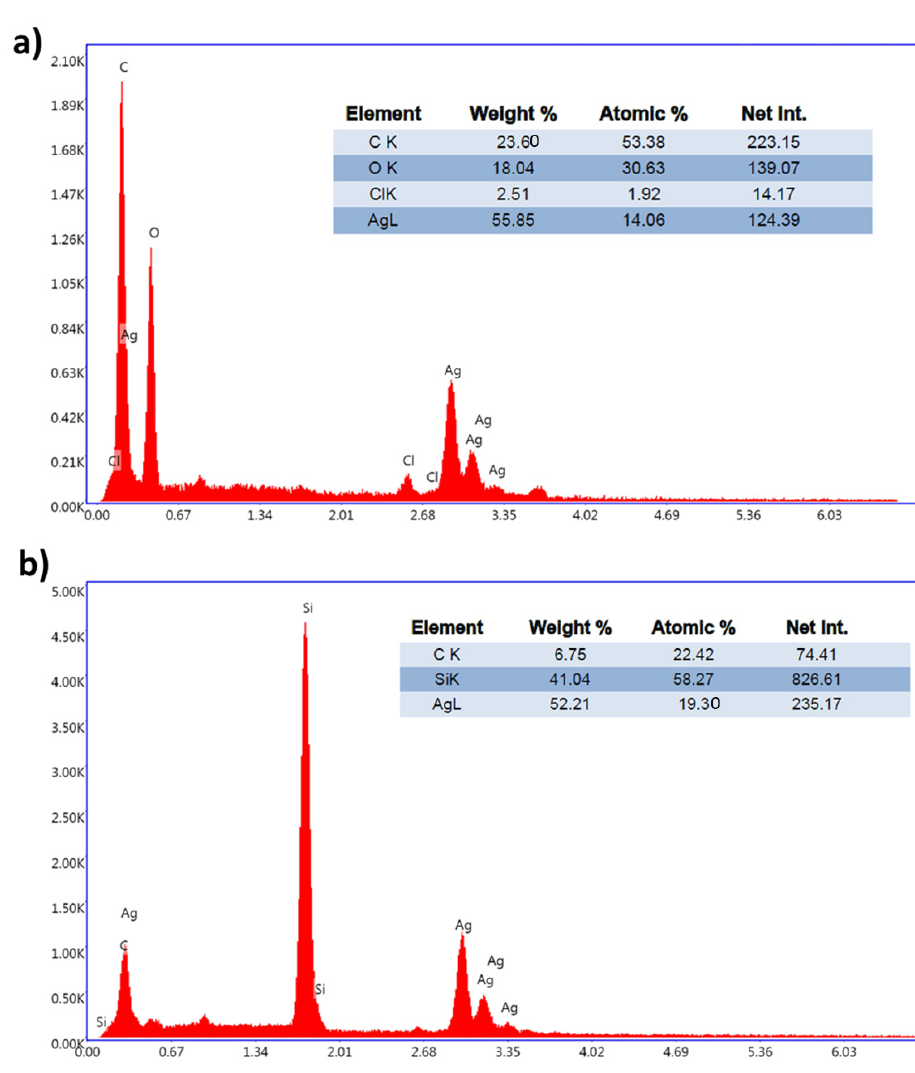
Figure 4. EDAX spectrum and the elemental composition of deposition onto the ( a ) copy paper substrates and ( b ) silicon wafer, respectively.